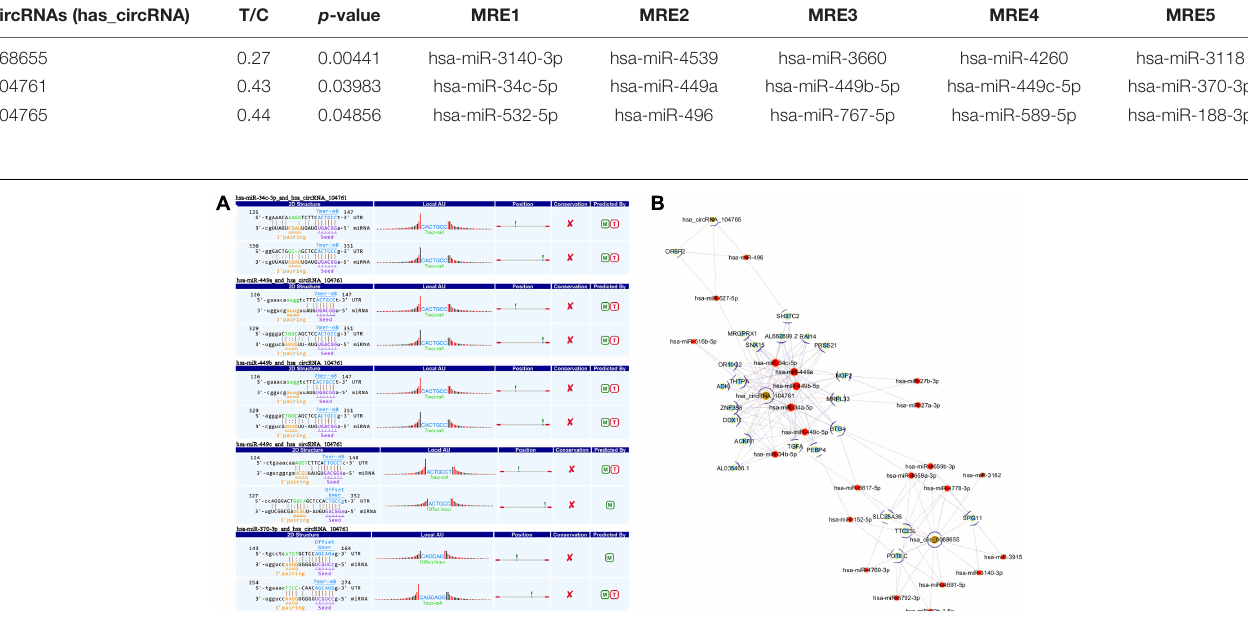
FIGURE 4 | The predicted miRNAs. (A) TargetScan and miRanda predicted the 5 most potential target miRNAs that may bind to circRNA _104761 and the binding site’s secondary structure. (B) Network of circRNA (068655, 104761, and 104765) -miRNA-mRNA.